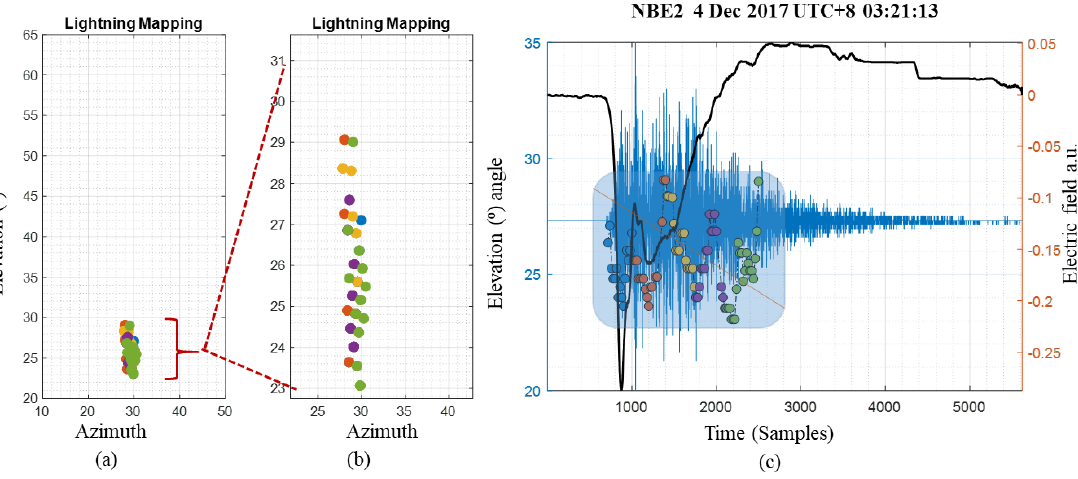
13 of 16 Figure 10. Interferometer data for NBE1: ( a ) lightning map plotted in elevation vs. azimuth; ( b ) expanded view of lightning map of ( a ); ( c ) the breakdown of each colored circle-marker denotes the elevation angles (altitude) vs. time. The second NBE2-initiated flash occurred sequentially with the NBE1 as the storm intensified on 4 Dec 2017, UTC+8 03:21:13. Figure 11 shows the estimated map of the light- ning source location of the FA and ITF observations for the positive NBE2. The color changes in Figure 11a, with time from blue to green, correspond to the lightning progres- sion time. Figure 11b shows the expanded view of the lightning map of a. The VHF radi- ation source for the NBE2 decreased in the elevation angle with an approximate range of 22° to 29° with small breakdown changes in the azimuth angles, corresponding to the tra-